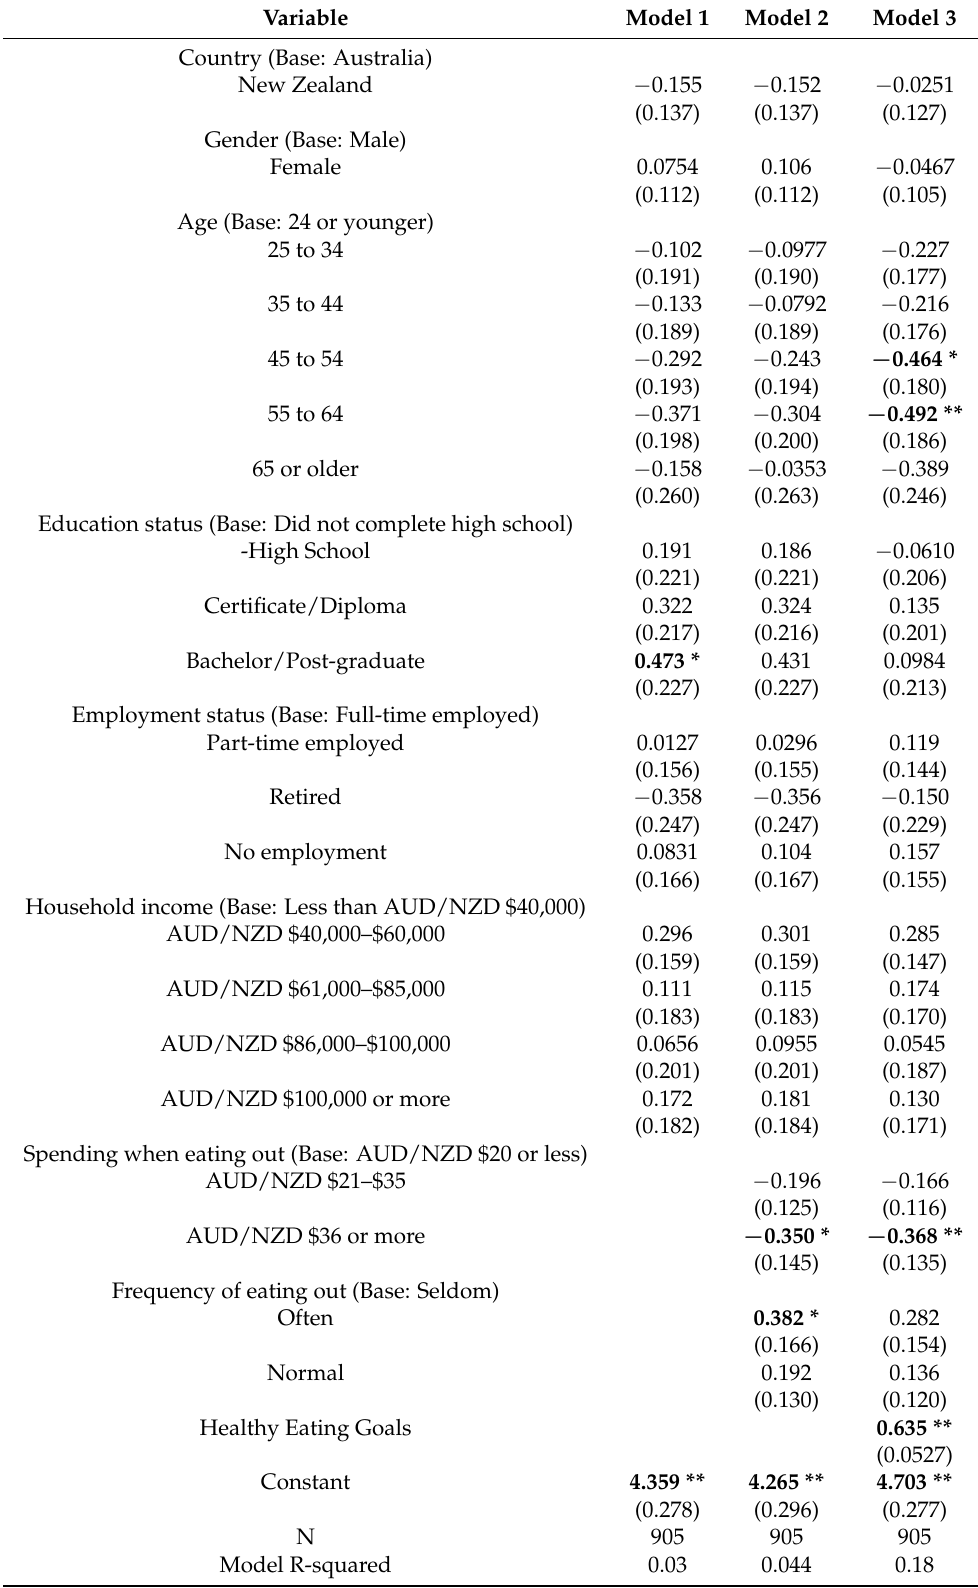
Table 2. OLS Regression